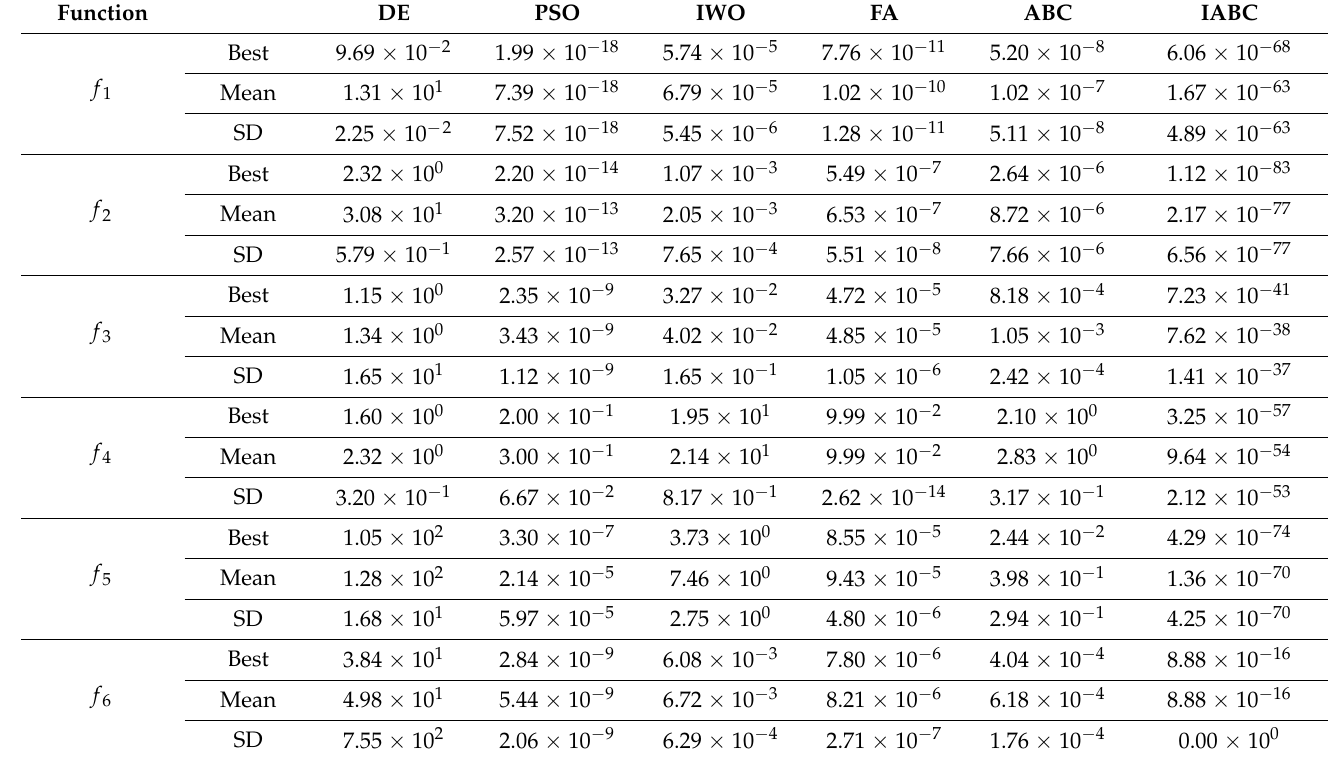
Table A2. Experimental results.